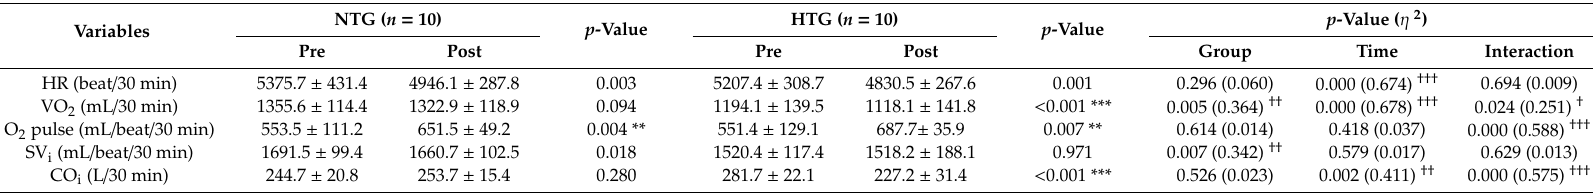
Table 3. Changes in hemodynamic function during submaximal cycle ergometer exercise for 30 min among the competitive runners before and after the tests. NTG ( n = 10) p HTG ( n = 10) p p -Value ( η 2 ) -Value -Value Variables Pre Post Pre Post Group Time Interaction HR (beat / 30 min) 5375.7 ±